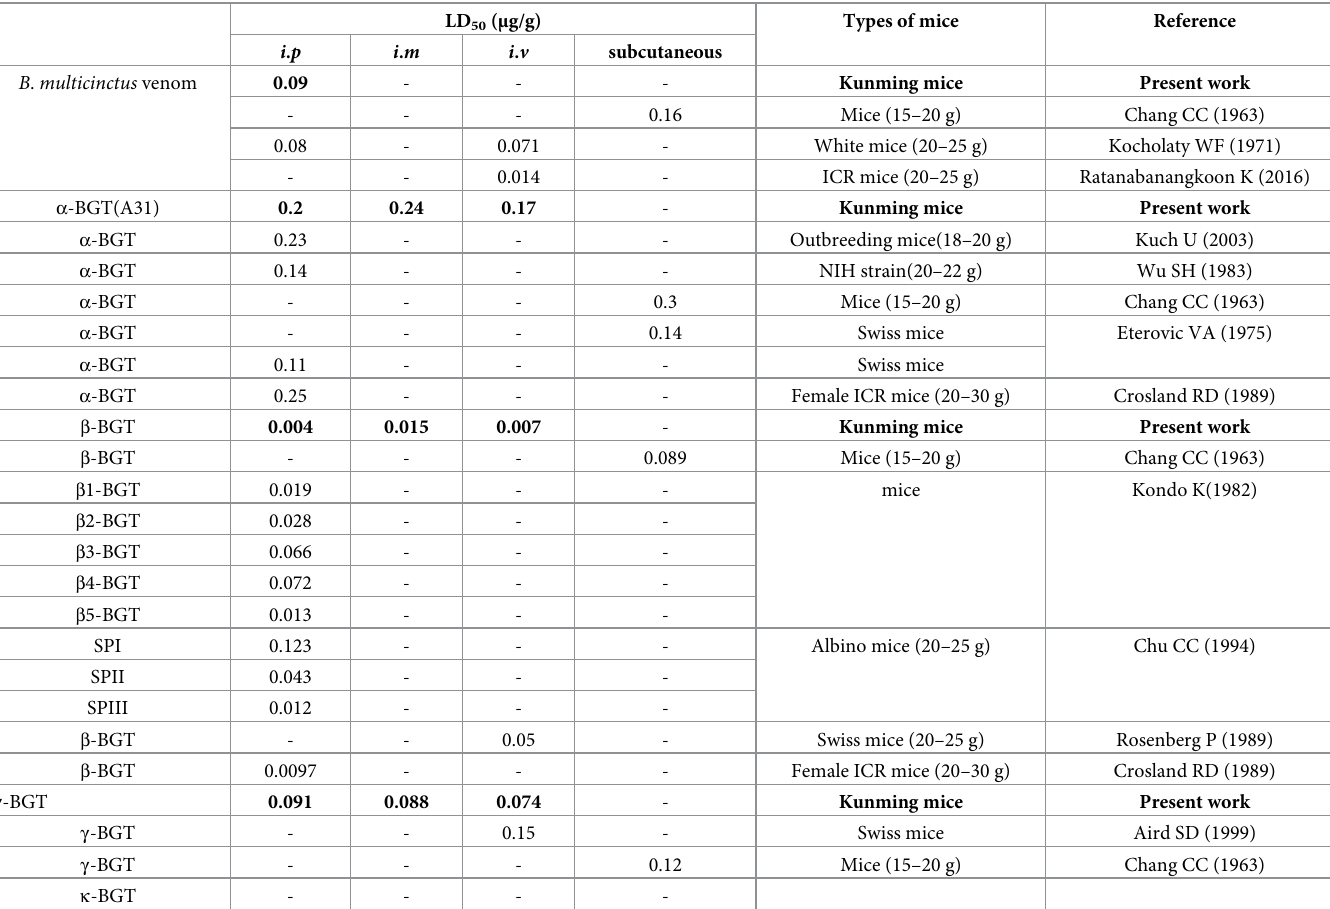
Table 1. Summary of the available LD 50 values of bungarotoxins via different administration